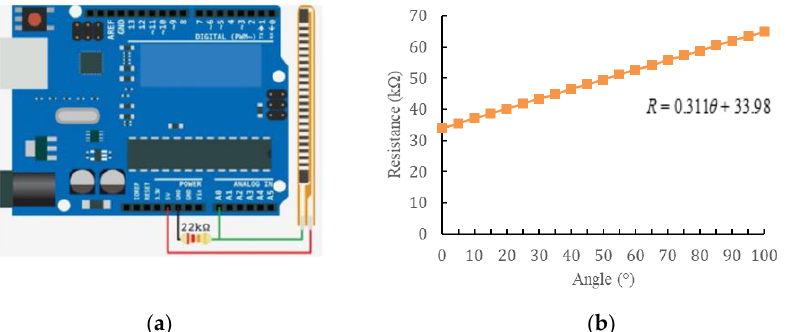
Figure 13. Flex Sensor 2.2. ( a ) Circuit diagram of bending sensor. ( b ) The relationship between the resistance value of the bending sensor and the bending angle.